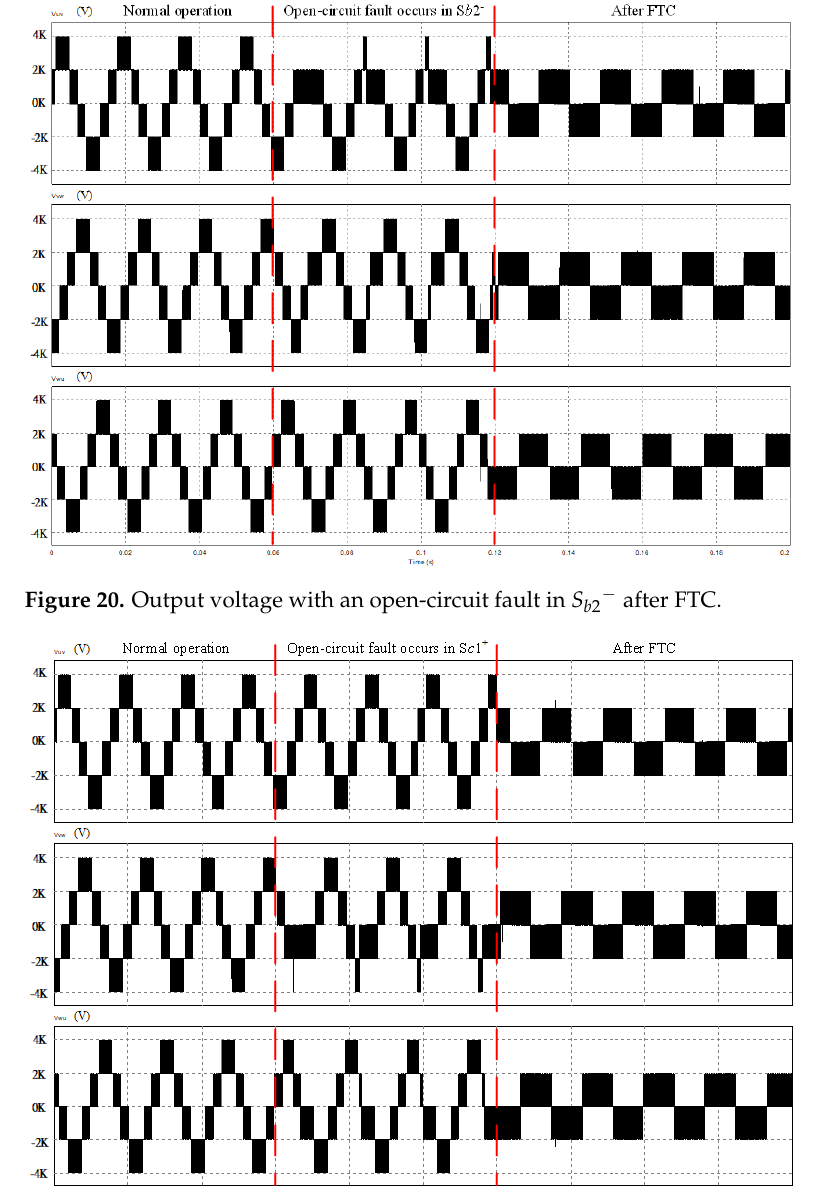
Figure 19. Output voltage with an open-circuit fault in S a1 + after FTC.